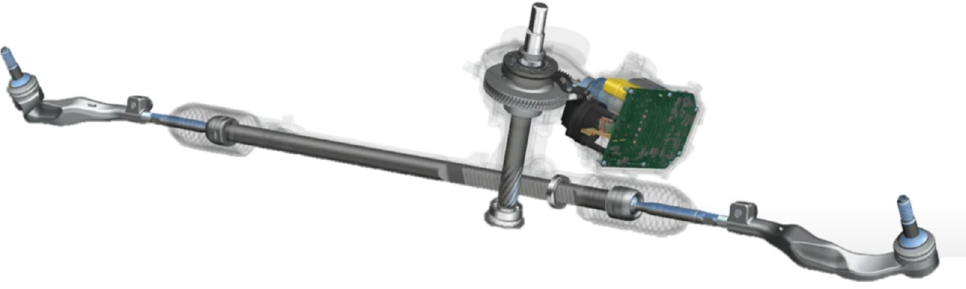
Figure 1. Single Pinion Assist EPS.